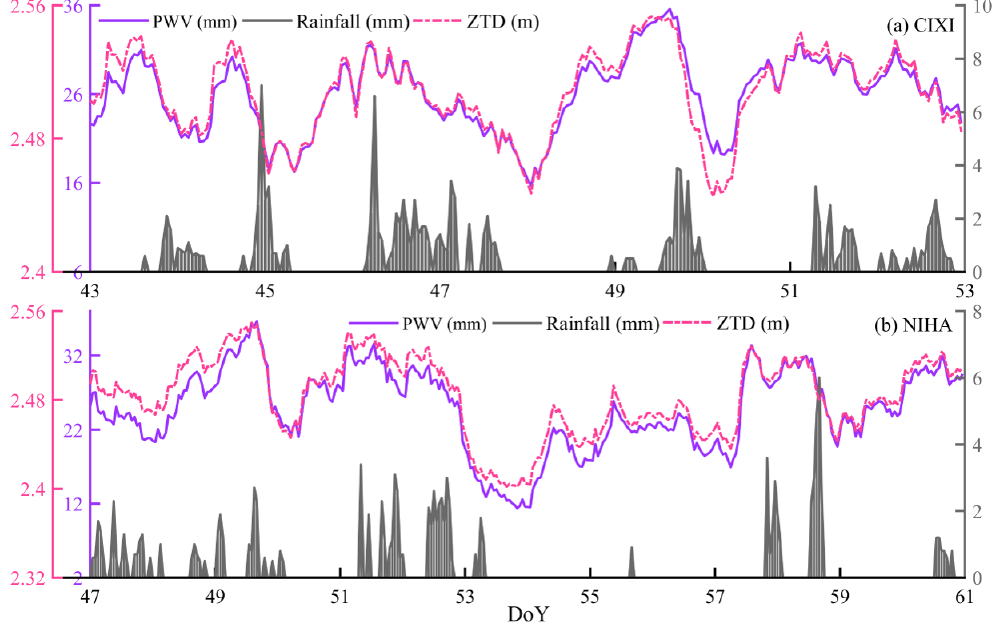
Figure 5. Changes between ( a ) PWV, ( b )ZTD and rainfall time series at CIXI and NIHA stations on DOY 43 – 45 and DOY 47 – 61 in 2019, respectively. (PWV: purple solid line; ZTD: red dotted line; Rainfall: black bars).